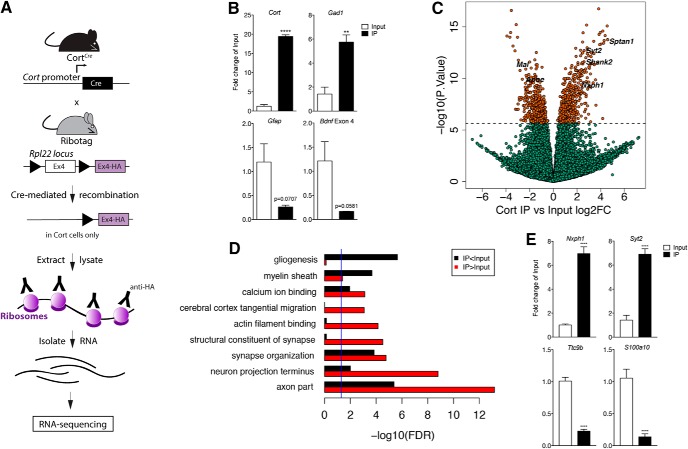
Translating ribosome affinity purification defines a unique molecular signature for cortistatin interneurons in the cortex. A, Locus of the ribosomal protein Rpl22 in the RiboTag mouse and breeding strategy used to obtain CortCre;Rpl22HA mice. Schematic of RiboTag experimental workflow. B, Validation of RiboTag allele expression in cortistatin neurons by qPCR for Cort as well as Gad, Gfap, and Bdnf exon IV (n = 3 per genotype, Student’s unpaired t test; data are presented as the mean ± SEM: **p < 0.01 ****p < 0.0001 vs control). C, Volcano plot of RNA-seq results with CortCre;Rpl22HA Input versus CortCre;Rpl22HA IP log2 fold change against −log10
p value. Orange dots represent genes that are significantly different in Input versus IP fractions, including Syt2, Nxph1, Mal, and Apoe. Green dots represent nonsignificant genes. See Extended Data Figures 2-1 and 2-2. D, GO terms in the molecular function, biological processes, and cellular component categories for genes enriched and de-enriched in Cort-expressing interneurons. See Extended Data Figure 2-3. E, qPCR analysis validating genes found to be differentially expressed in Input versus IP RNA sequencing results (n = 3 per genotype, Student’s unpaired t test; data are presented as the mean ± SEM: ****p < 0.0001 vs control).